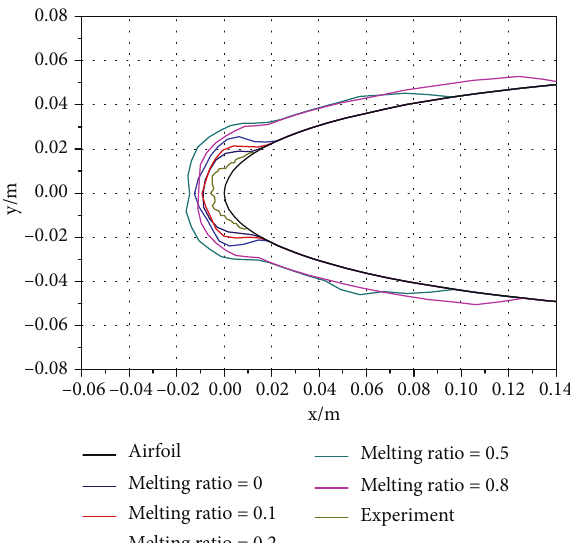
Figure 7: Comparison of ice shapes for di ff erent melting ratios.